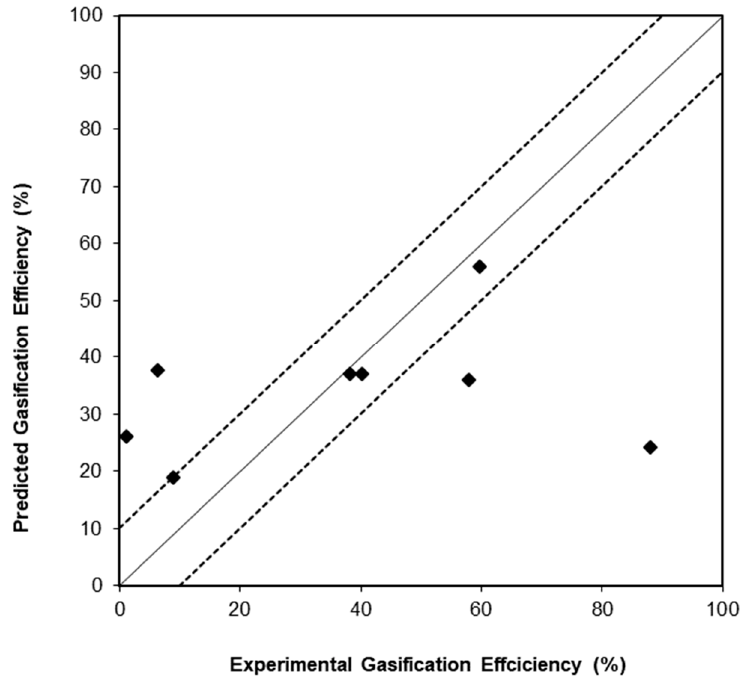
Figure 8. Predicted vs. experimental gasification efficiency of the SCWG of cellulose for 10-s residence time runs.